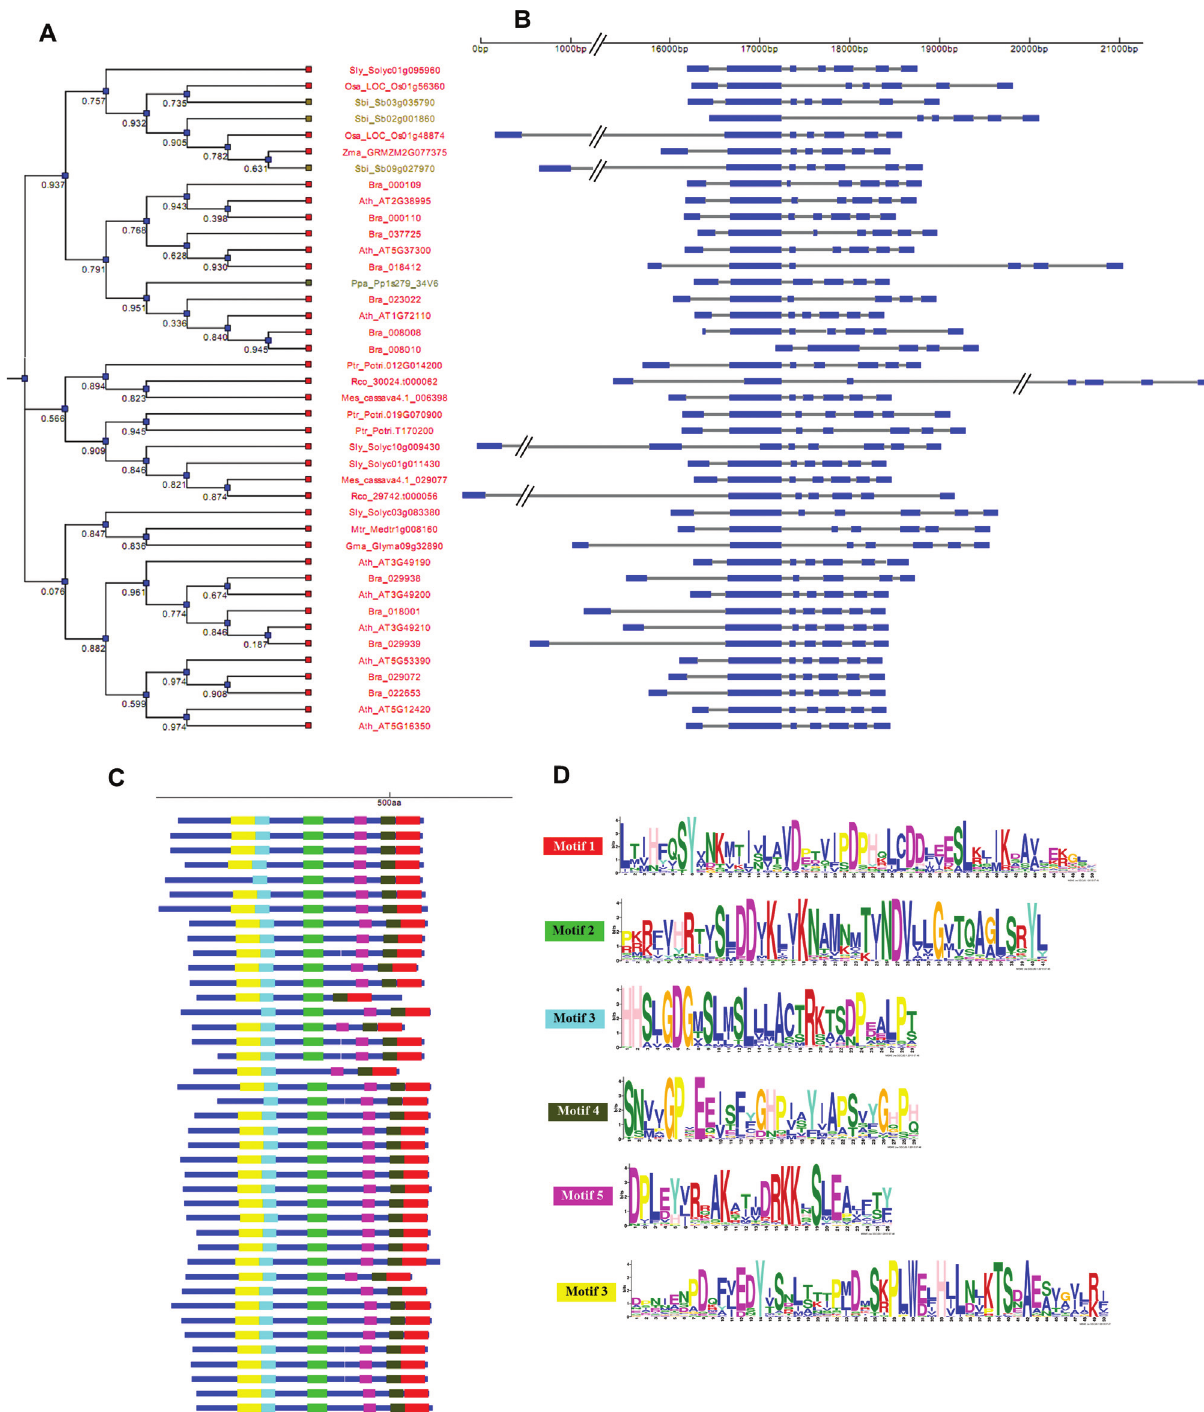
Figure3 -WS/ DGAT genestructureandorganizationandconservedmotifsidentifiedinplantgenomes.Dendrogramofsequencesclusteredaccordingto the presence and similarity of identified protein motifs (A). Diagram displaying information of the gene structure for each sequence (B). Conserved mo- tifs identified on protein sequences (C) and sequence logo of the conserved motif (D). The species included in this analysis are listed in the Table 1. Exon sequences are represented as blue boxes and the gray bars represent introns. The bootstrap values are given below the branches of the